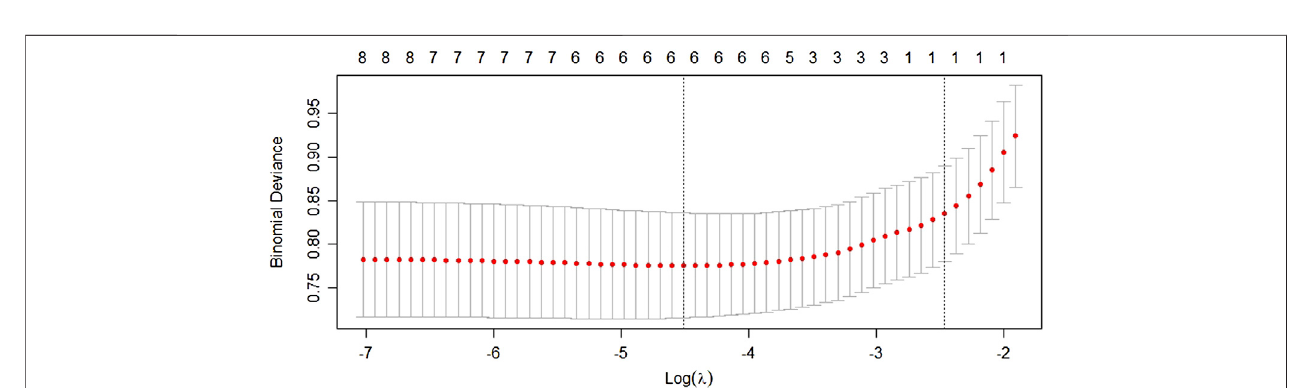
FIGURE 2 | LASSO analysis after the univariate